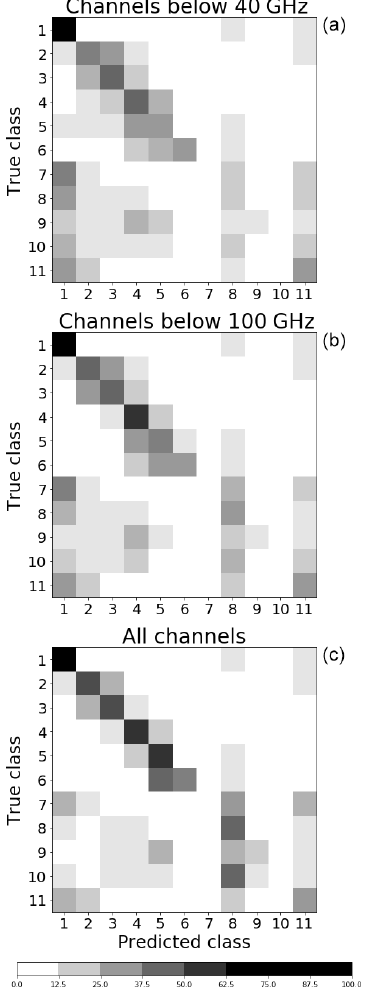
Figure 3. Confusion matrix over the ocean for the cloud type clas- sification for the three MW frequency ranges: below 40GHz (a) , below 100GHz (b) , and all channels (c) . The cloud type numbers are detailed in Table